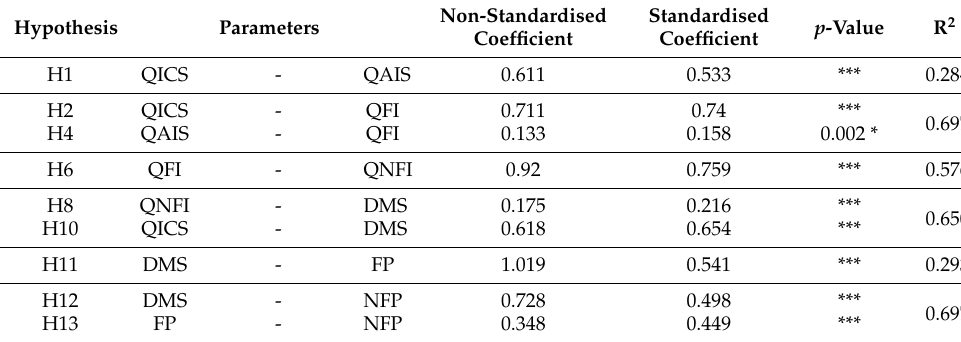
Figure 3. Path diagram of the revised theoretical model. Legend: QICS—Quality of ICS; QAIS—Quality of AIS; QFI—Quality of FI; QNFI—Quality of NFI; DMS—Decision Making Decision; FP—Financial Performance; NFP—Non ‐ Financial Performance. Table 4. Results of the assessment of the revised theoretical